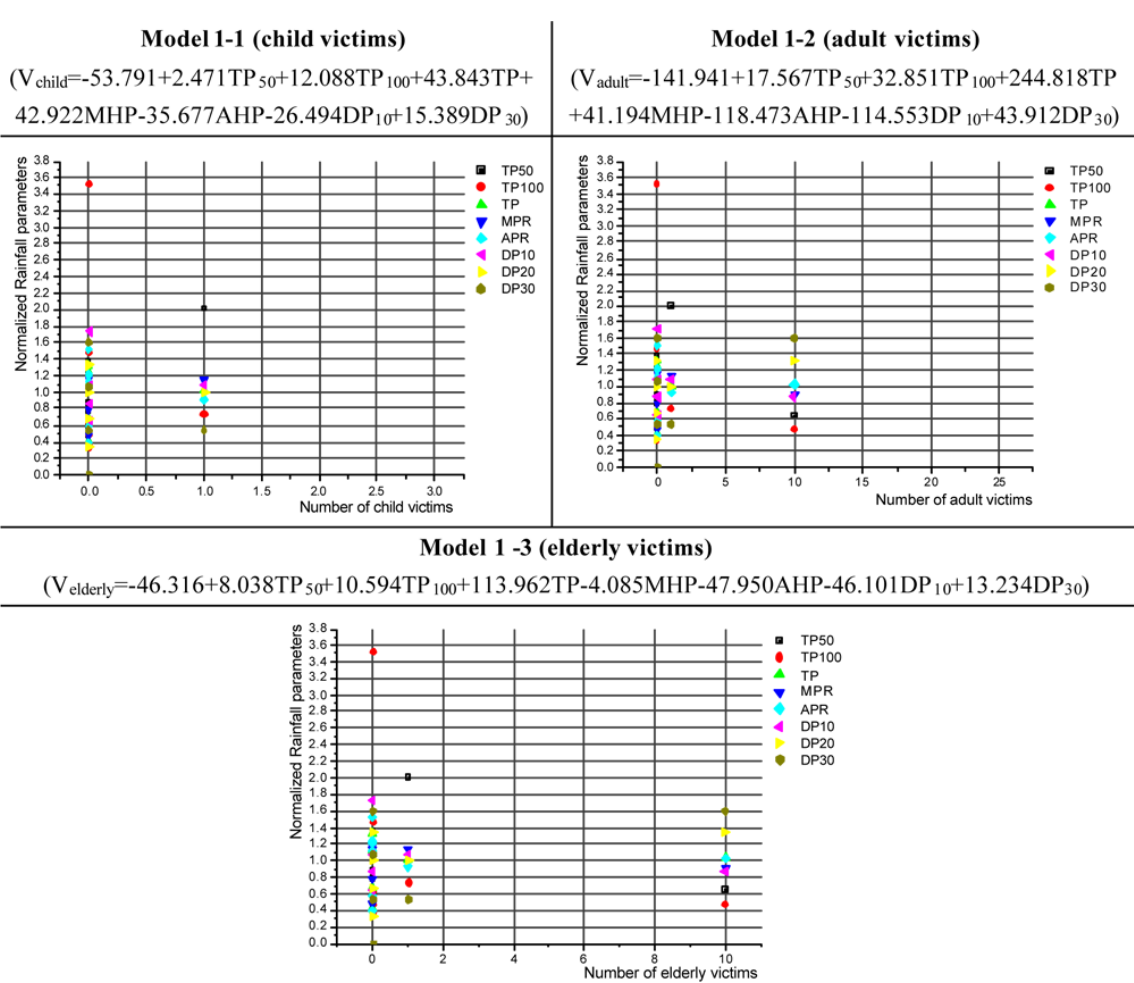
Fig. 11. The relationship between each extreme rainfall parameter and victims in 3 different age groups.